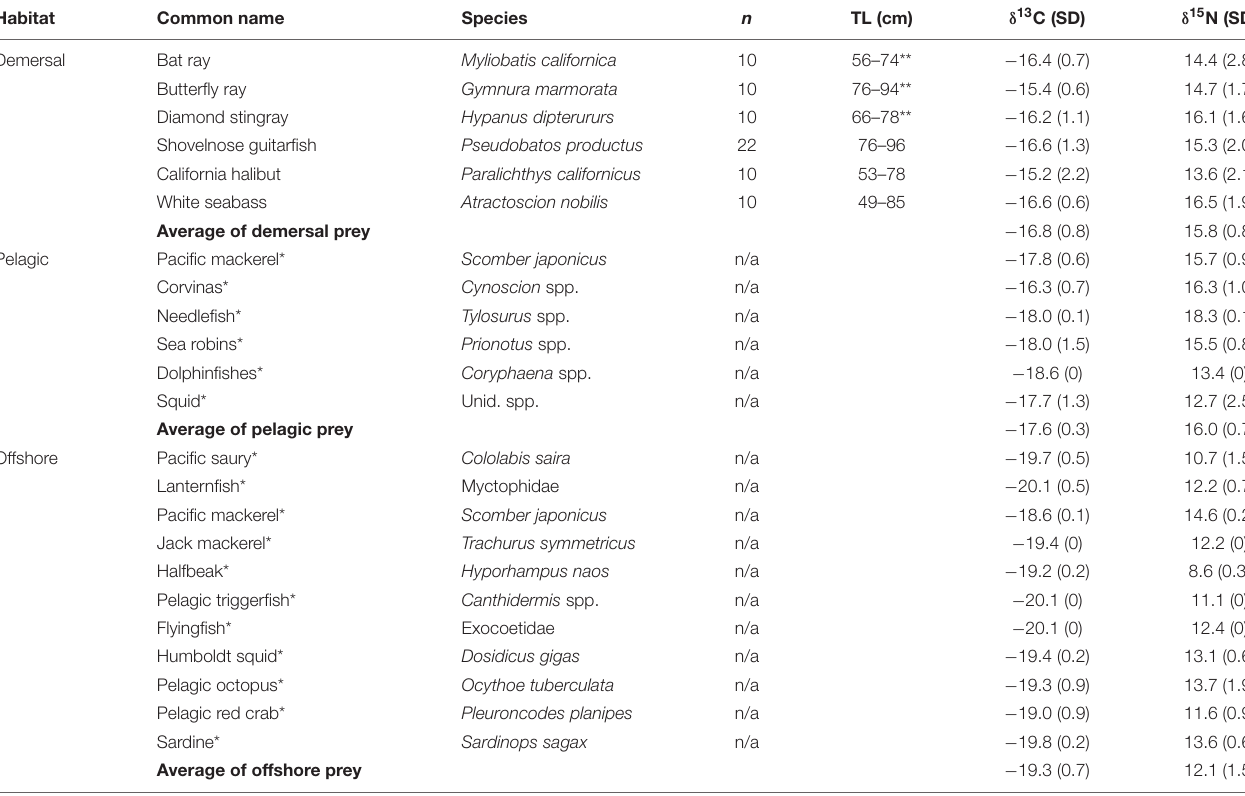
TABLE 2 | Isotope ratios of potential prey of immature white